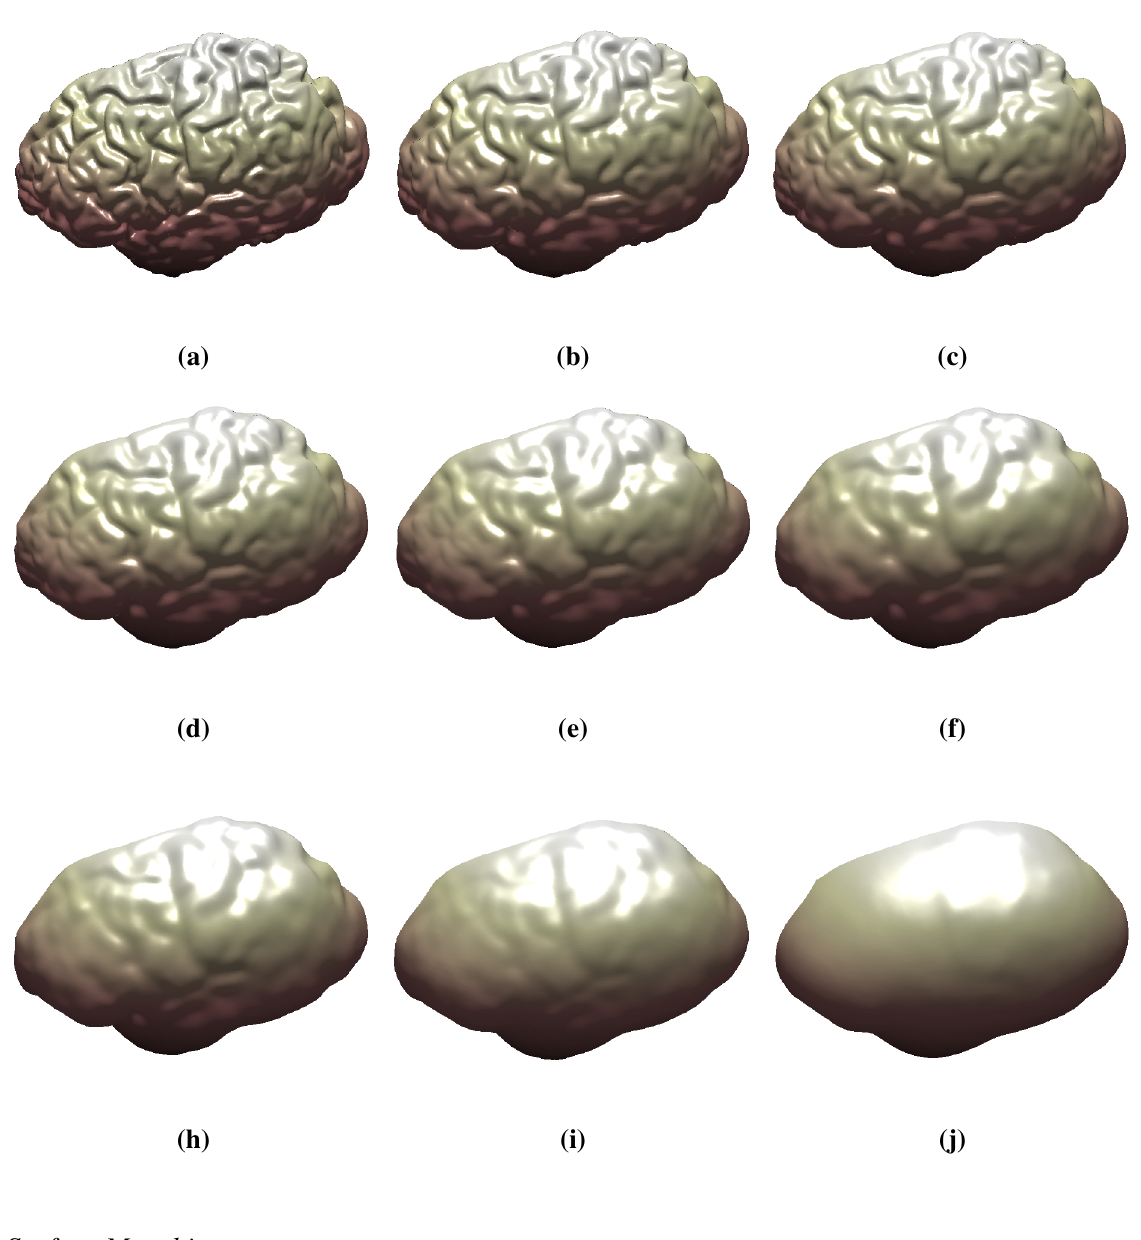
Figure 7. Result of the multi-scale representation of a brain surface. ( a ) The original brain surface. ( b – i ) The multi-scale representation of the brain obtained from the proposed algorithm. The approximation levels of the multi-scale representation decreases from the fine-scale (see ( b )) to the coarse-scale (see ( i )). Note that from (b) to (i), geometric characteristics, like sulci on the brain, are fading out. This is consistent with our algorithm, which coarsens the ( λ, H ) representation throughout the